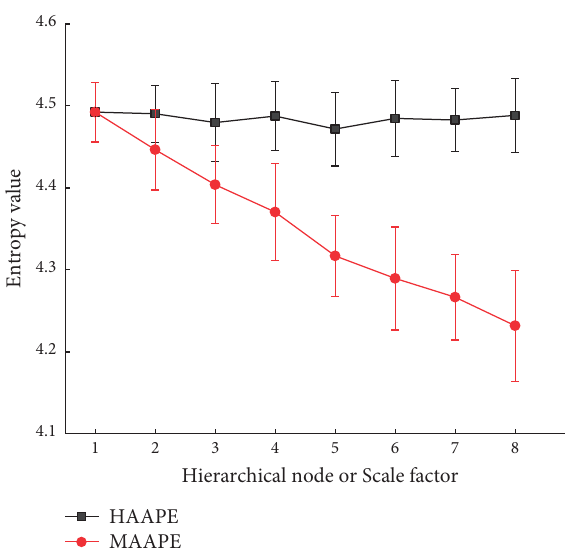
Figure 3: Entropy value curves of two different